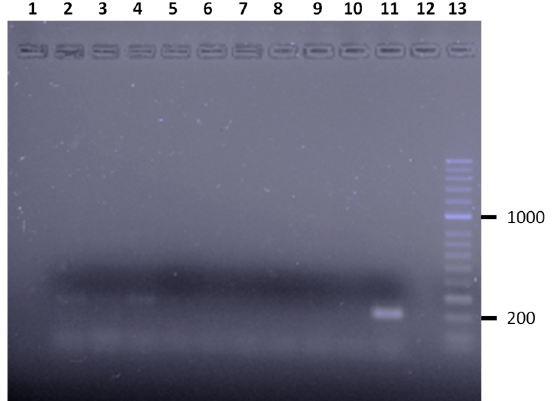
Figure 2. Results of the m-PCR assay for the simultaneous detection of Salmonella spp. and S. enteritidis , S. typhimurium , and S. typhi from various Anolis sp. analyzed. Lane 2, 3, and 4, amplification fragment of the ompC gene characteristic of Salmonella spp. obtained from Anolis sp. analyzed in this study. Lane 5 to 10, Anolis sp. negative for Salmonella spp. Lane 11, positive control. Lane 12, control negative. Lane 9, molecular size marker (HyperLadderTM 50 bp, Bioline).